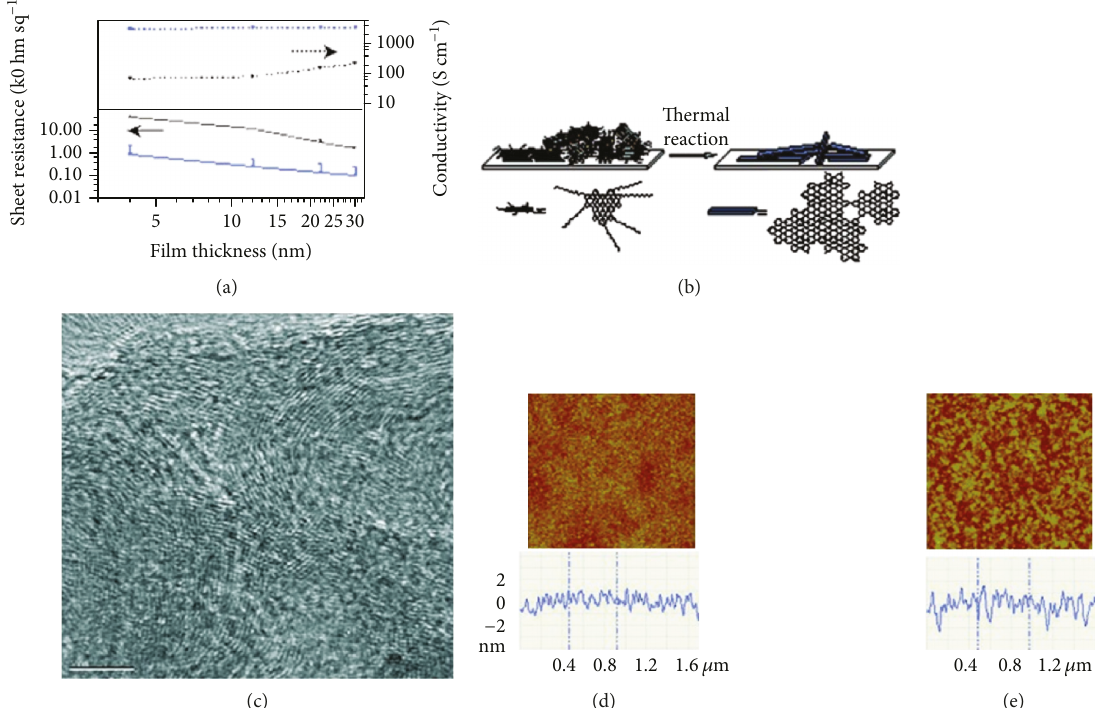
Figure 3: (a) Sheet resistance (solid curves with half error bars in the plus direction) and corresponding average conductivity (short dashed curves) of the transparent graphene fi lms (TGFs) as a function of the fi lm thickness, with the plot in the log-log scale. Black and blue curves denote the TGFs produced on quartz and SiO /Si, respectively. (b) Illustration of the mechanism of the intermolecular condensation of 2 nanographene 1 into graphitic networks. (c) A representative HRTEM image of a TGF (scale bar: 5nm). (d) and (e) AFM height images ( 2 × 2 μ m 2 ) of 4 and 30 nm thick TGF surfaces, respectively (color scale: black to bright yellow, 10nm). Each image is accompanied with a cross-sectional plot which has the same vertical scale